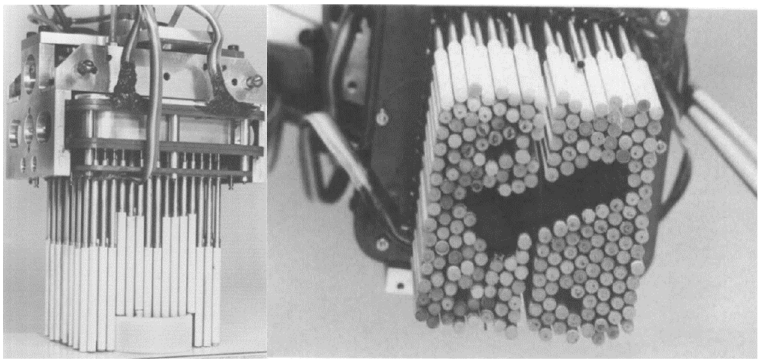
Figure 1. The Omnigripper.